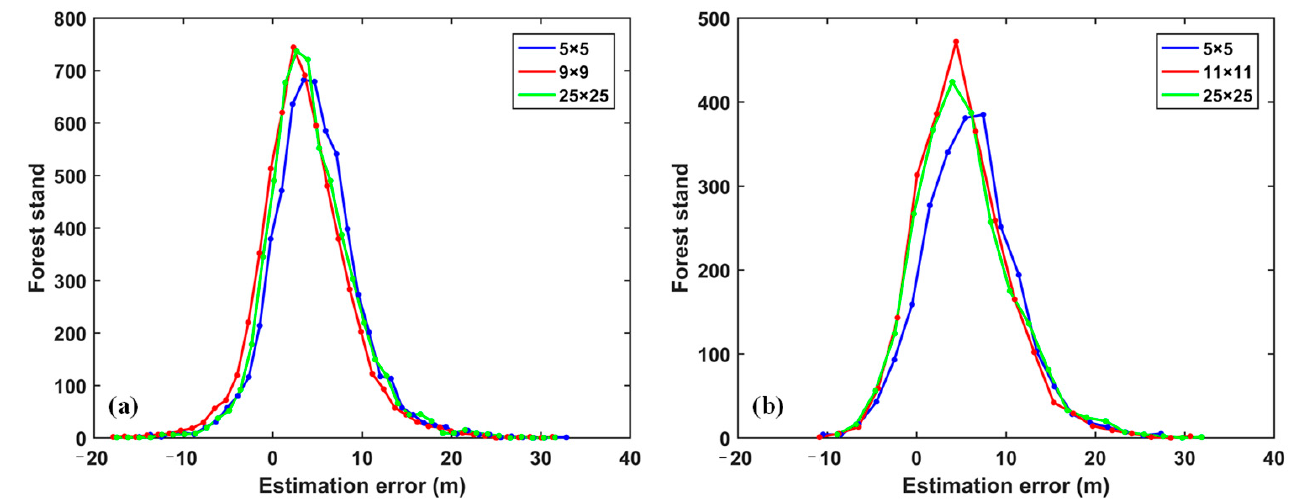
Figure 12. Estimation error based on forest stands: ( a ) Mabounie; ( b ) Mondah.